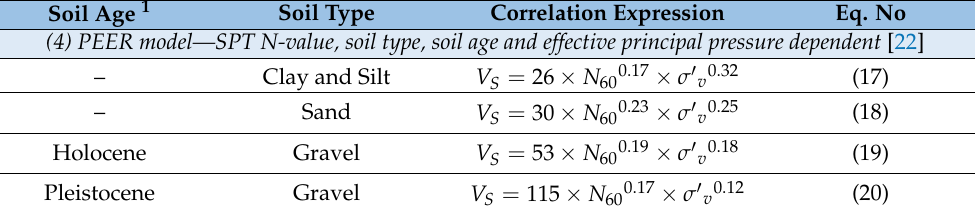
Table 1. Cont. Soil Age 1 Soil